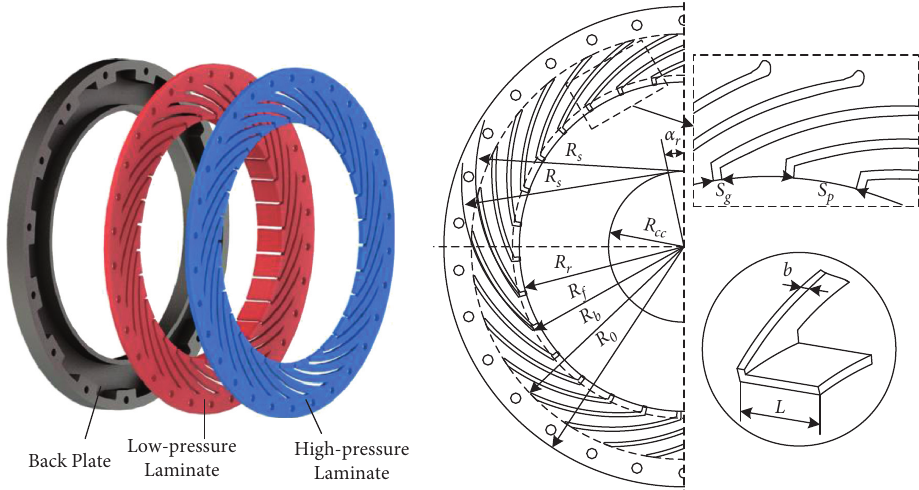
Figure 1: Structure of noncontacting finger seal.